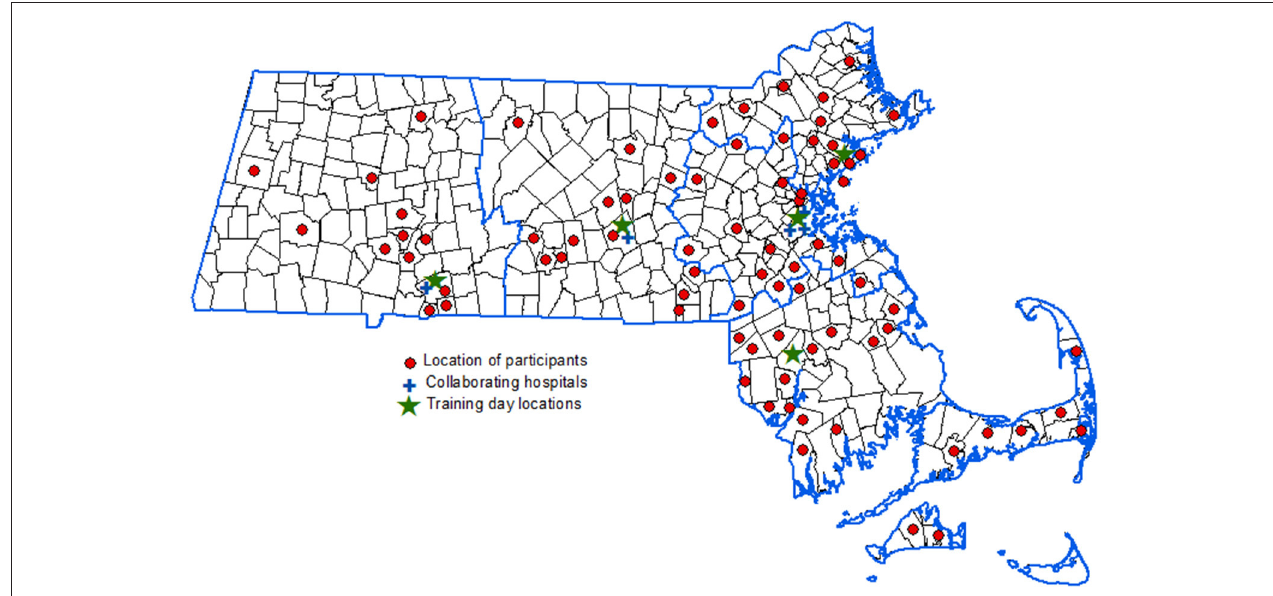
FIGURE 1 | Distribution of participants across Massachusetts. Map of Massachusetts with the 5 EMS Regions outlined in blue. Red circles indicate towns and agencies represented by participants, blue crosses represent the participating hospitals, and the green stars denote the location of the educational sessions. The map was created using ArcGIS ® software by Esri. ArcGIS ® and ArcMap TM are the intellectual property of Esri and are used herein under license. Copyright © Esri.